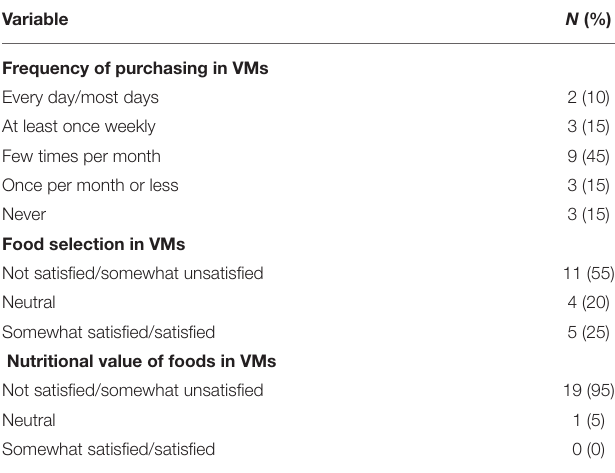
TABLE 2 | Vending machine purchasing